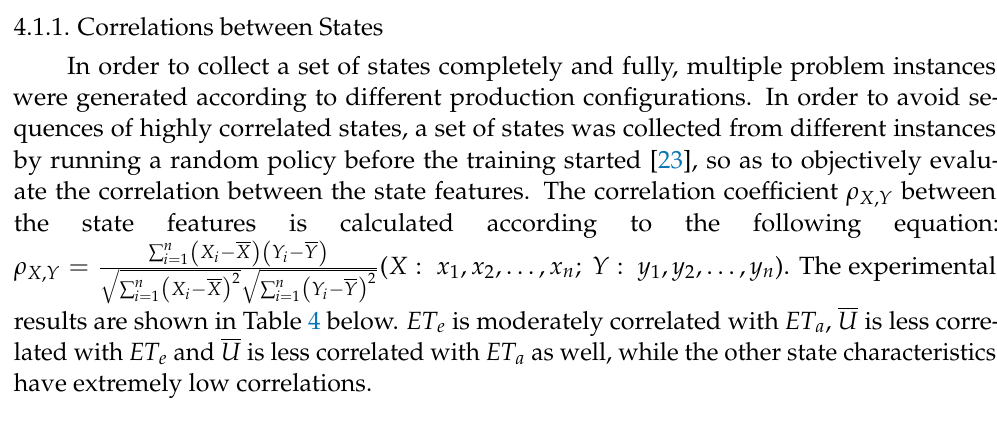
Table 4. Correlation coefficients between state